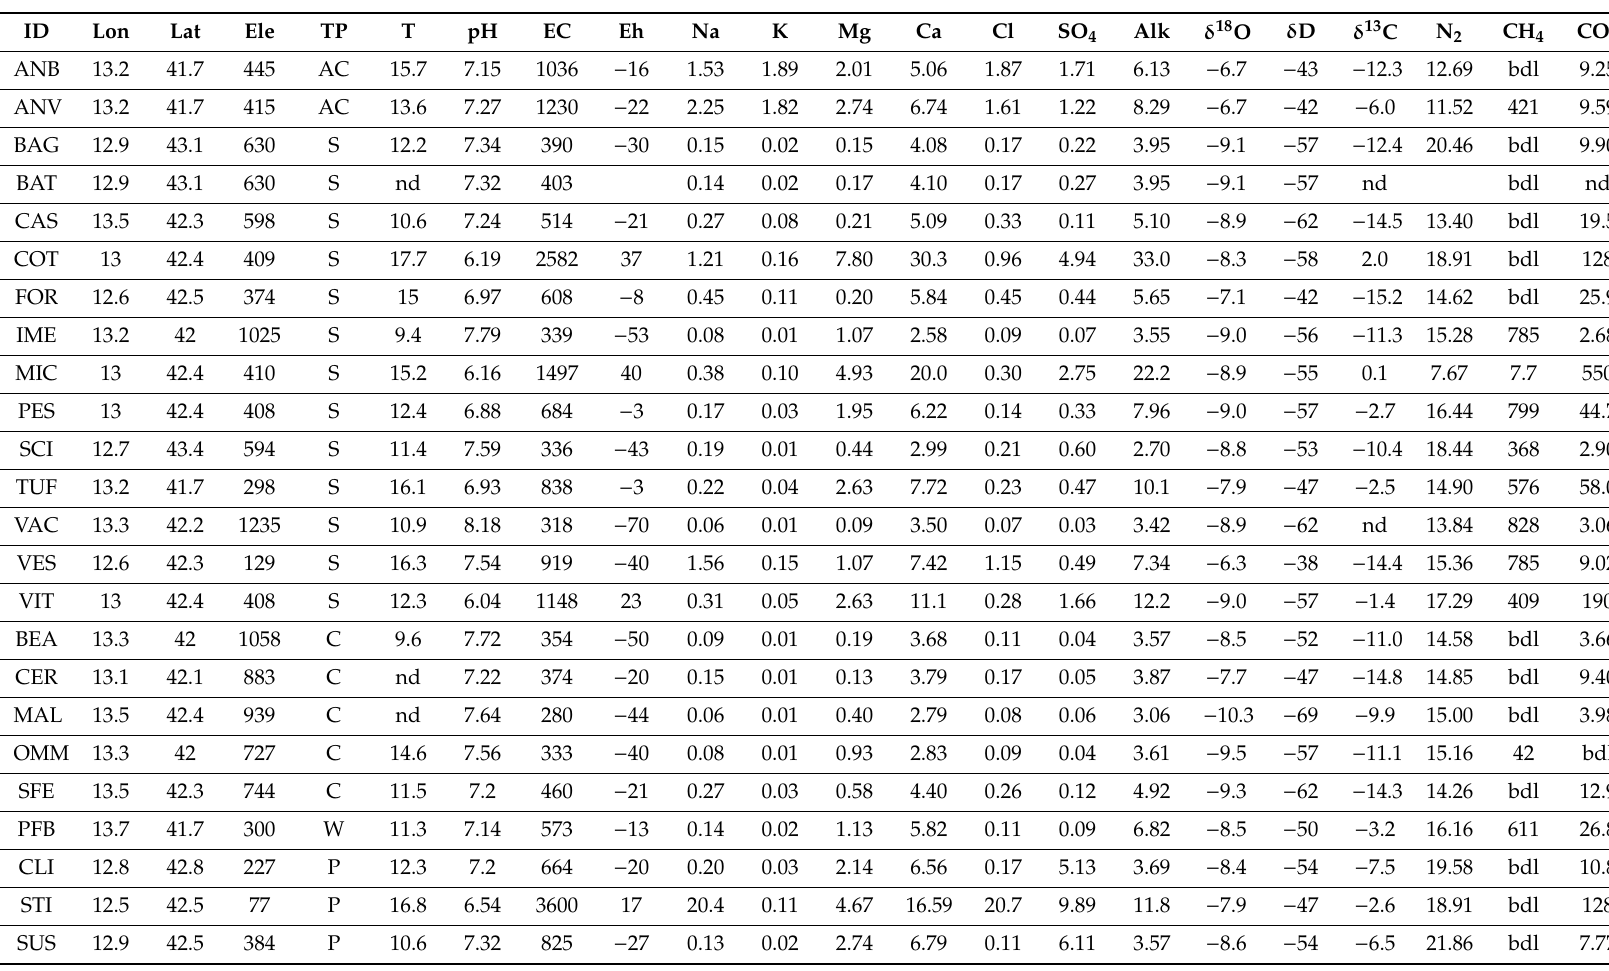
Table 1. Summary of field and laboratory parameters. Longitude and latitude in decimal degrees WGS84, elevation in m a.s.l., type of site (artificial cave, spring, cave, well, pool), temperature in ◦ C, pH, electric conductivity in µ S cm − 1 , major ions in mEq L − 1 , alkalinity in mEq L − 1 , δ 18 O and δ D in % (cid:24) V-SMOW, δ 13 C of TDIC in % (cid:24) V-PDB, dissolved N 2 and CO 2 in cc L − 1 STP, dissolved CH 4 in ppmv; nd is not determined, bdl is below detection